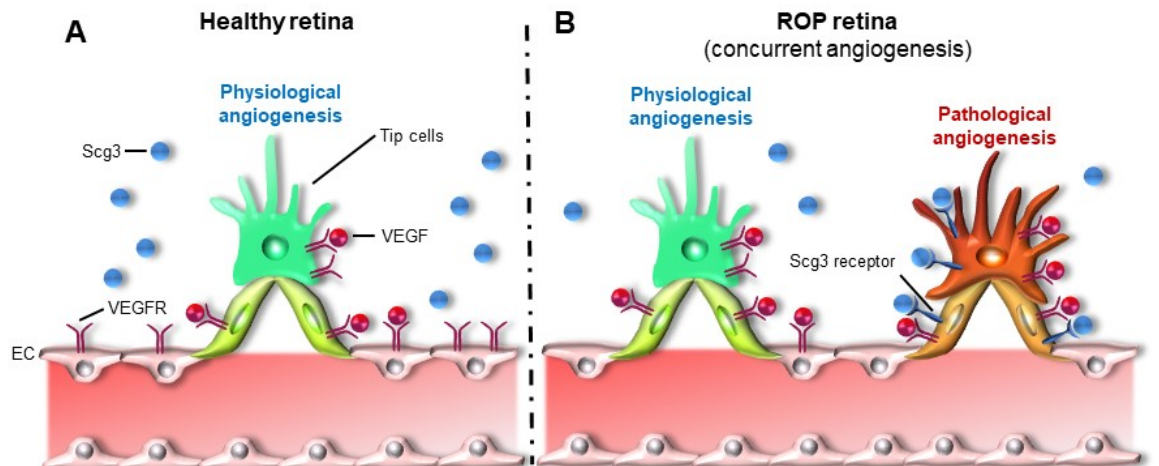
Figure 5. Concurrent physiological and pathological angiogenesis in ROP: ( A ) Physiological angiogenesis in the healthy retina and ( B ) Concurrent physiological and pathological angiogenesis in the ROP retina. Scg3 receptor is upregulated on pathological neovessels with minimal induction of Scg3 ligand itself, as in contrast to induction of VEGF ligand in ROP.